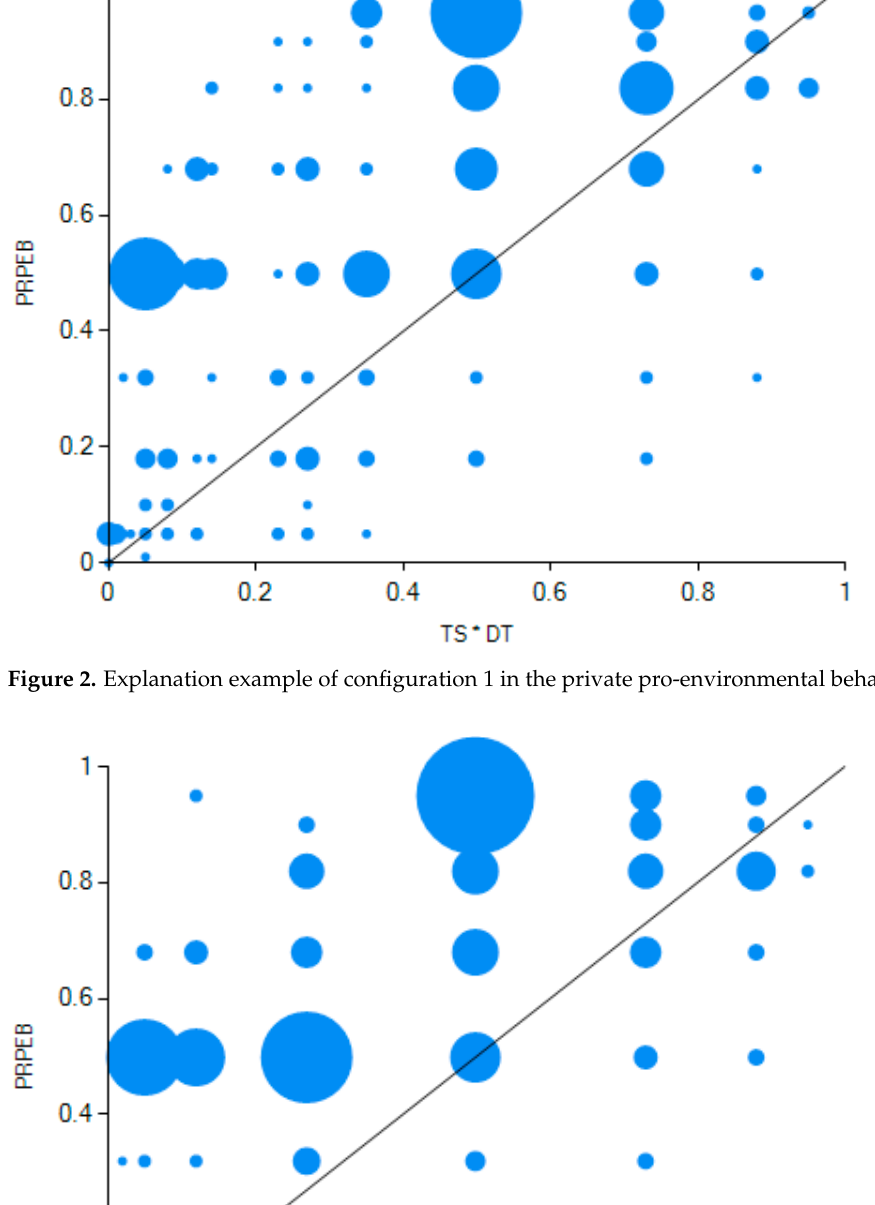
Figure 3. Explanation example of configuration 2 in the private pro-environmental behavior mode.